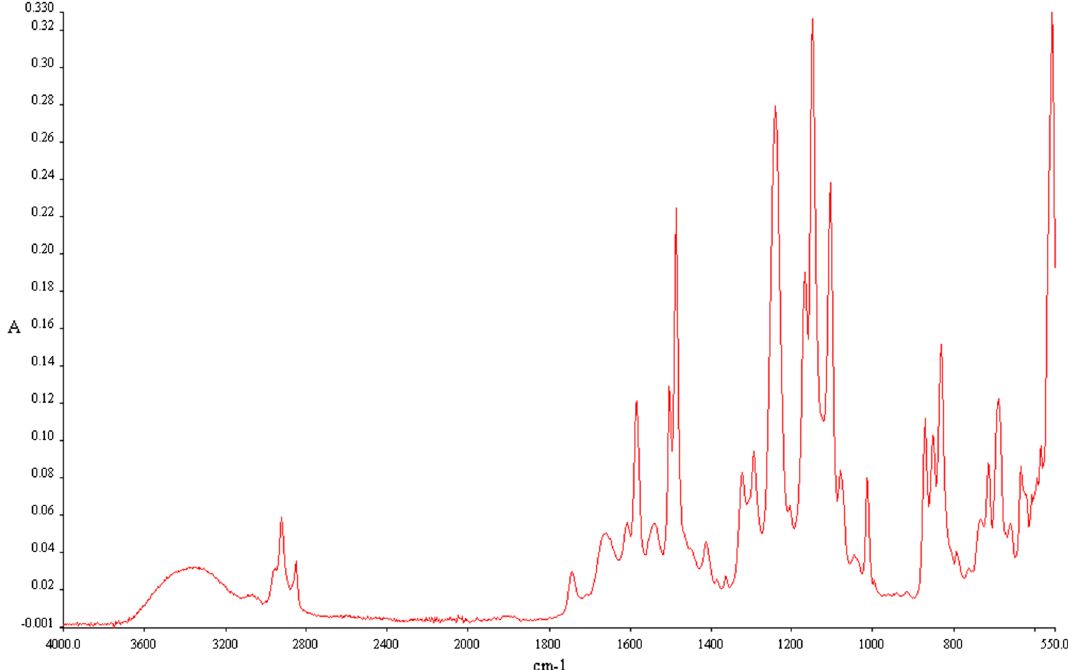
Fig. 2 FTIR spectra of the virgin Saehan